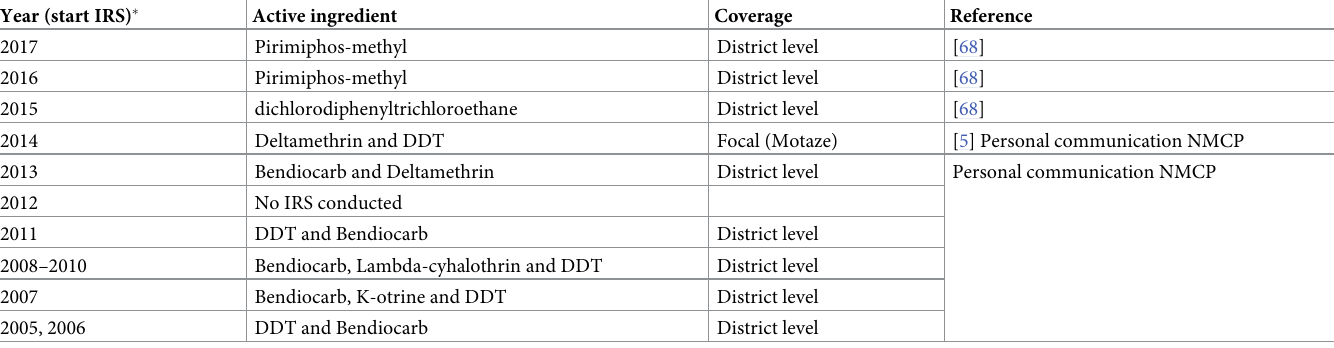
Table 1. History of indoor residual spraying (IRS) campaigns in Magude